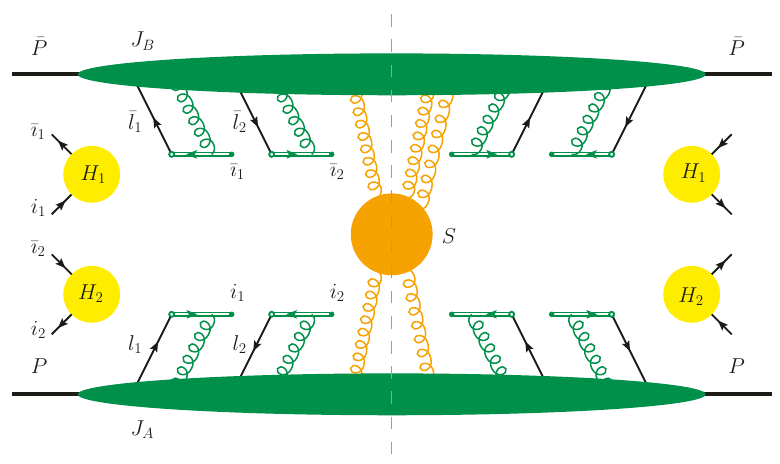
Figure 2 . Structure of the TMD cross section after collinear gluons have been decoupled from the hard